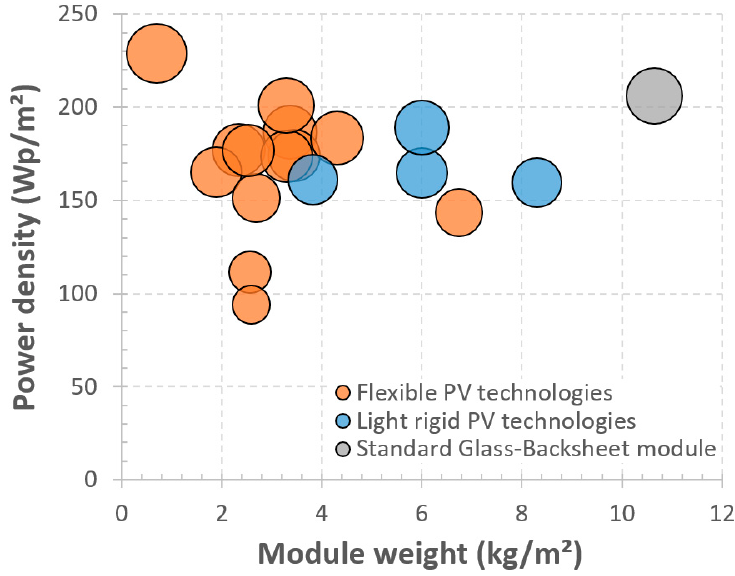
Figure 7. Number of flexible and light (nonflexible) modules in Table 2 (commercial brands) and their weight, where each bubble is a product. The flexible modules do not include the typical 6 kg/m 2 metal sheet of the car body.